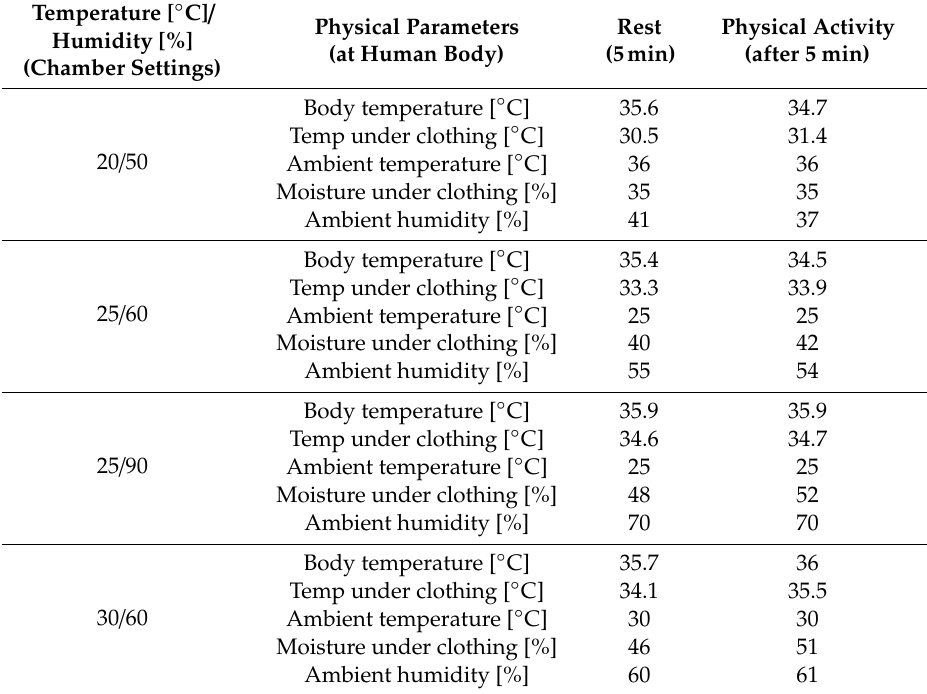
Table 1. Temperature and humidity values at rest and after physical activity.